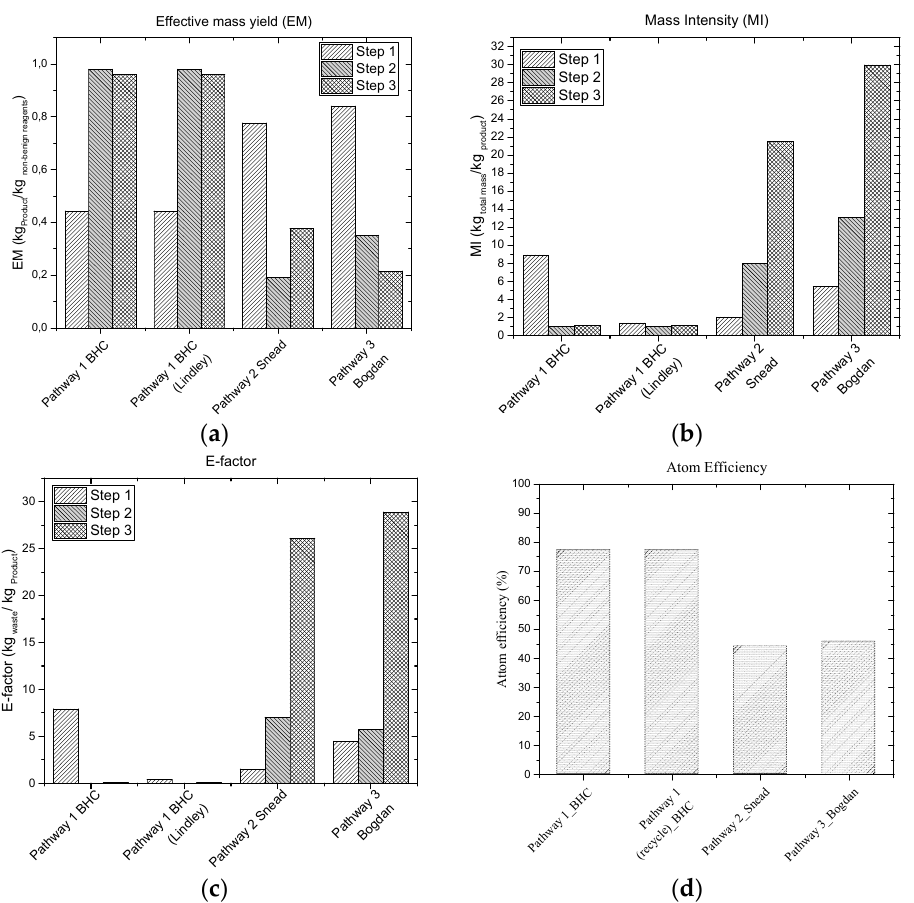
Figure 6. “Green” metrics evaluation for the reaction pathways found in the reaction database: ( a ) effective mass yield (EM) metric, ( b ) mass intensity (MI) metric, ( c ) E-Factor metric and ( d ) atom efficiency metric.